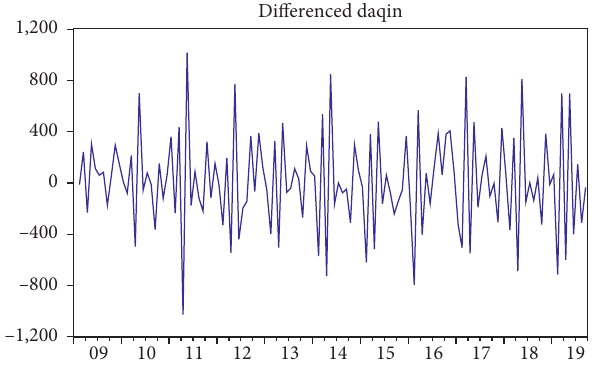
Figure 2: First-order difference sequence of x